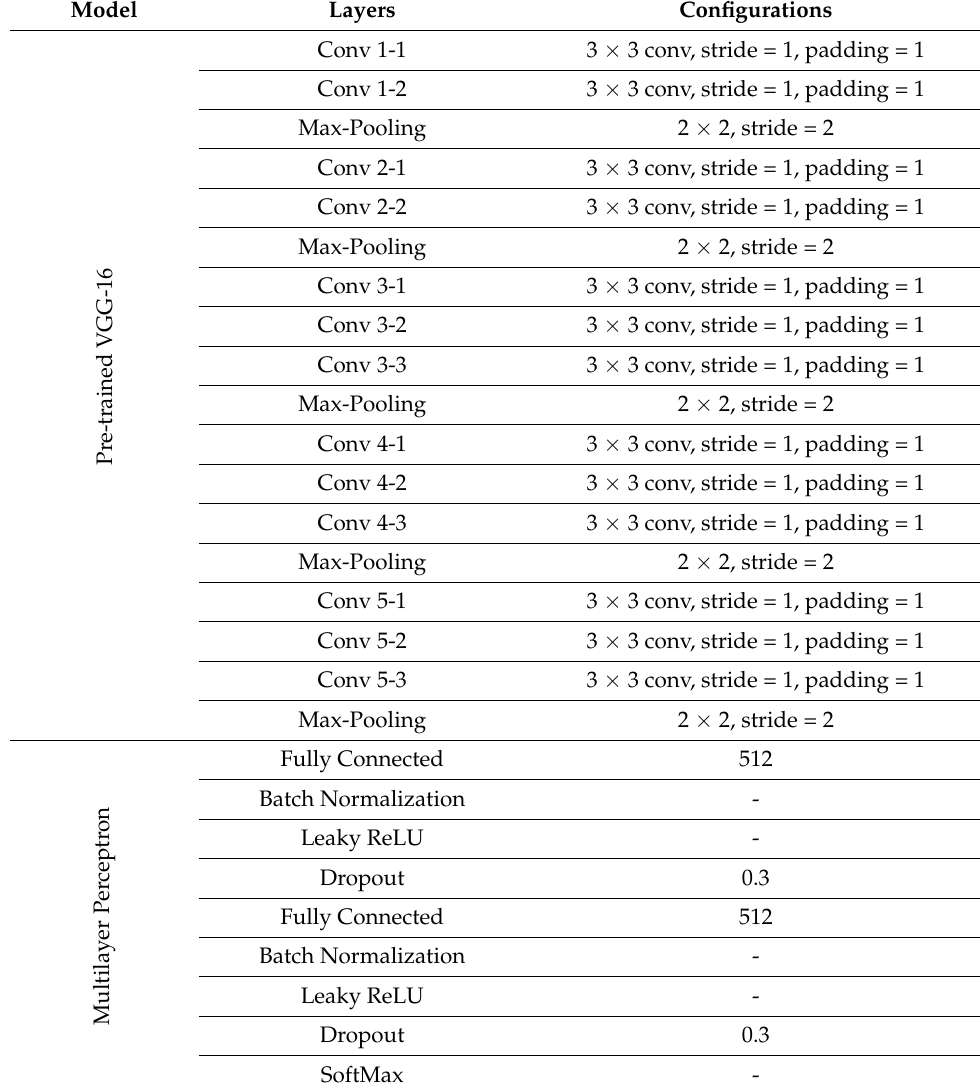
Table 1. Layer-wise architecture of the proposed VGG16-MLP model.